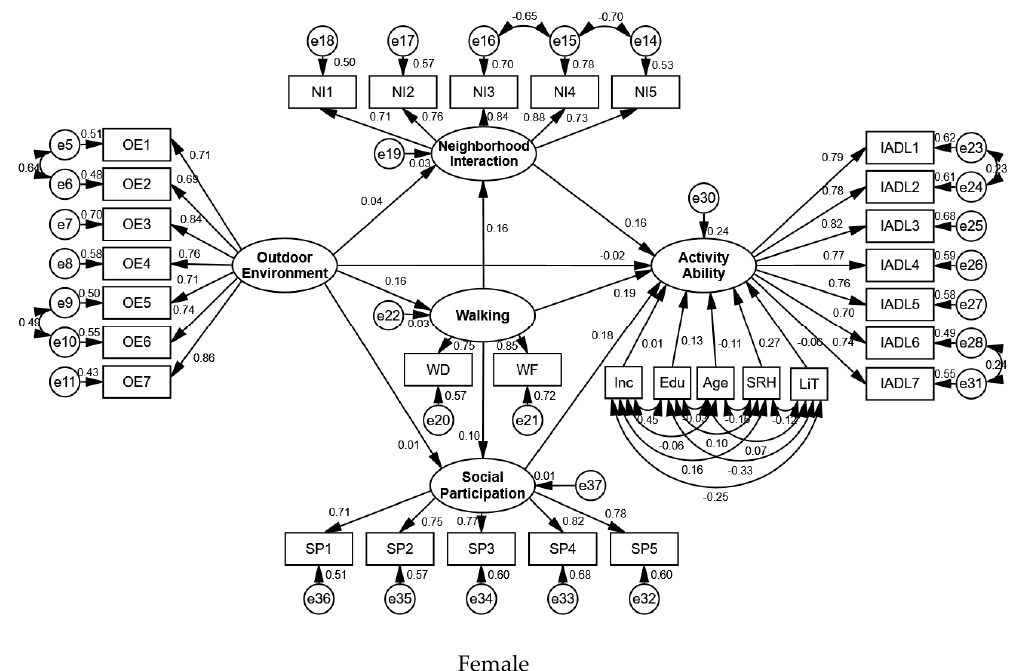
Figure 6. Standardization coefficients for female sample model.